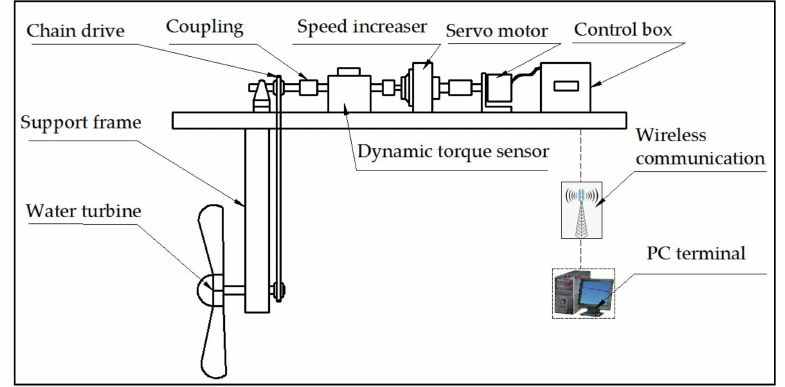
Figure 14. Schematic diagram of the hydraulic turbine experimental